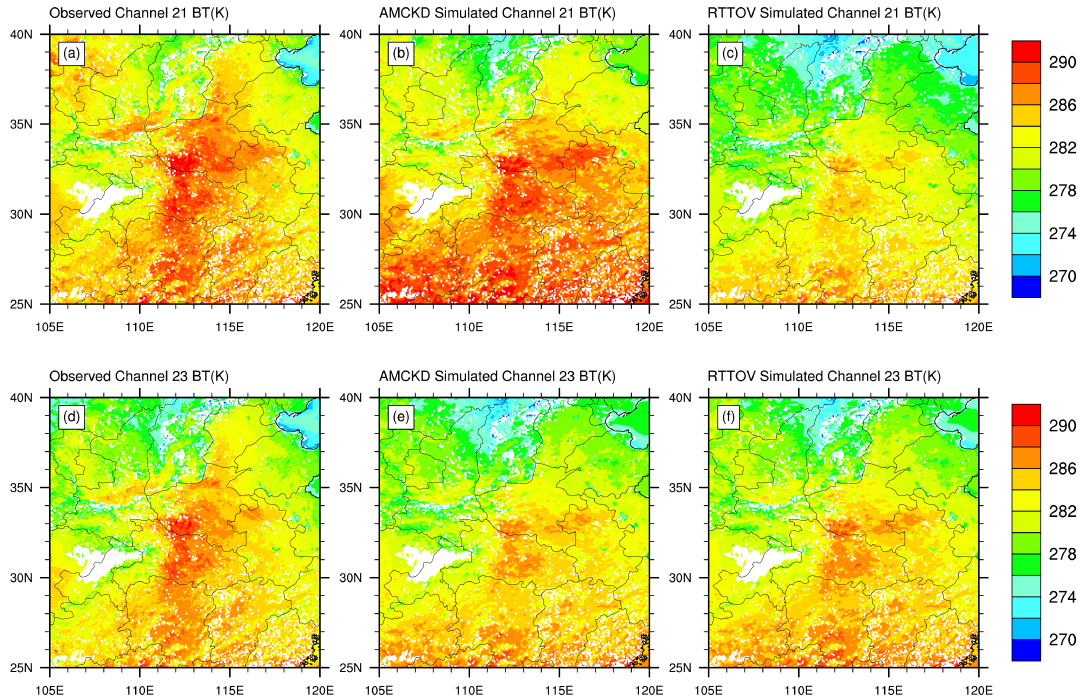
Figure 7. Comparison between simulated brightness temperature by AMCKD ( b , e ) and RTTOV ( c , f ) and observations ( a , d ) of MERSI 4.0459 µ m (channel 21) ( a – c ) and 10.7139 µ m (channel 23) ( d – f ) channels with a clear sky. The blank area is the cloudy